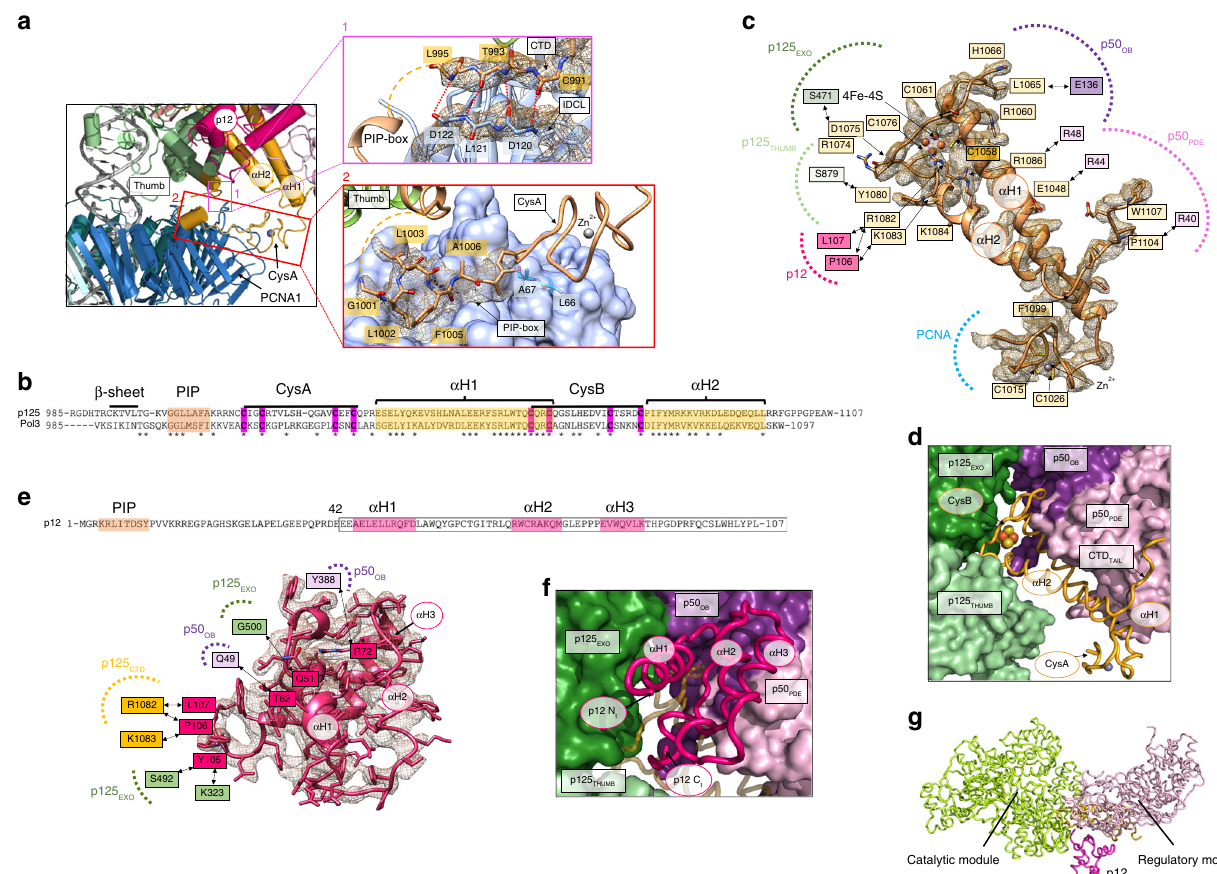
Fig. 2 Cryo-EM density and model of selected regions of the Pol δ – DNA – PCNA complex. a Map regions showing the critical interactions tethering the polymerase to PCNA. Models are colored by domain. Inset 1: main-chain hydrogen bonds between the CTD of p125 and the IDCL of PCNA, indicated as red dotted lines. Residues involved in the interactions are labeled and colored by domain. Amino acid side chains are not shown. Inset 2: interaction between the p125 PIP-box and PCNA. b Sequence alignment of the CTD of human and Saccharomyches cerevisiae Pol δ and motifs. Asterisks correspond to conserved residues. Conserved cysteines in CysA and CysB motifs are highlighted in magenta. c Map region and model of the CTD of p125. Interfacial residues are boxed and colored by domain. Residues participating in polar interactions are connected by double-headed arrows. Some of the amino acid side chains are omitted for clarity. d Model region showing the pocket between the p125 and p50 subunits, where the CTD is inserted. p125 and p50 domains are shown as surfaces, and the CTD as a ribbon. The FeS cofactor and zinc ion in the CTD are shown as spheres. The p12 subunit was removed for clarity. e Map region and model of the p12 subunit of Pol δ , and p12 amino acid sequence and motifs. The segment of the p12 sequence that was modelled is boxed. Interfacial residues are boxed and colored by domain. Residues participating in polar interactions are connected by double-head arrows. f Model region showing the position of p12 relative to the holoenzyme. p12 and CTD are shown as ribbons and the latter is shown with enhanced transparency. p125 and p50 domains are shown as surfaces. g Model of human Pol δ in ribbon representation, showing the p12 subunit connecting the catalytic and regulatory